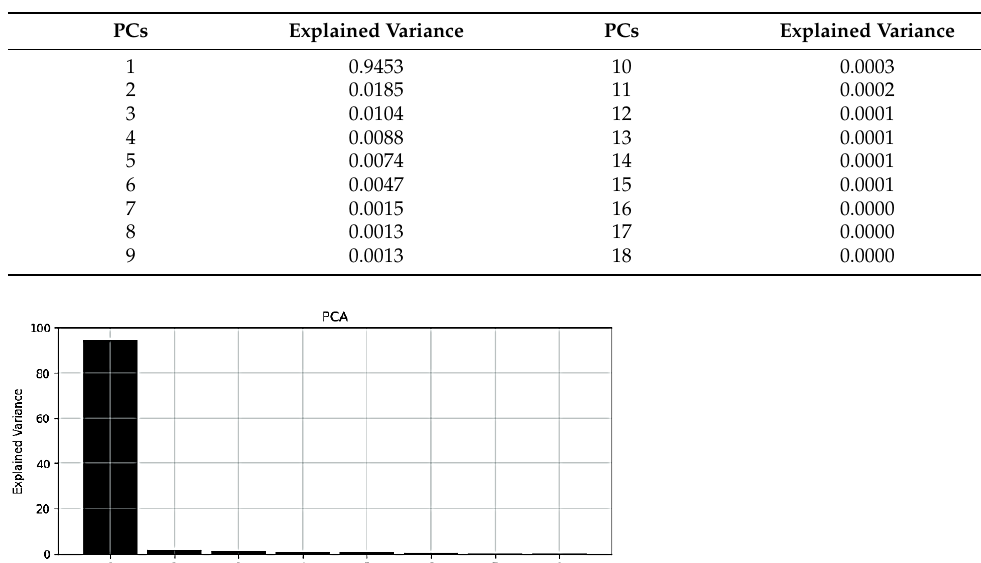
Table 9. The Degree of Variability Explained by PCs.